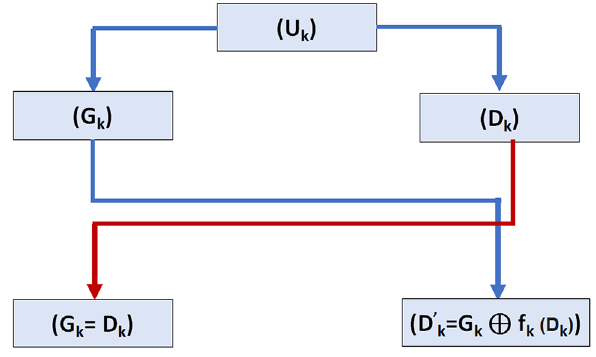
Fig. 1 Feistel’s classic round